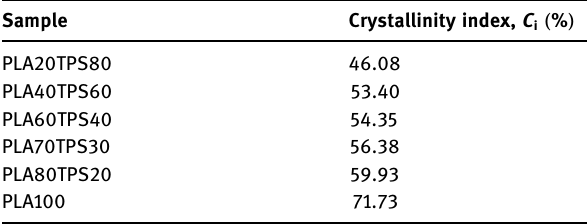
Table 3: Crystallinity index of neat PLA and PLA/TPS blend bionanocomposites Sample